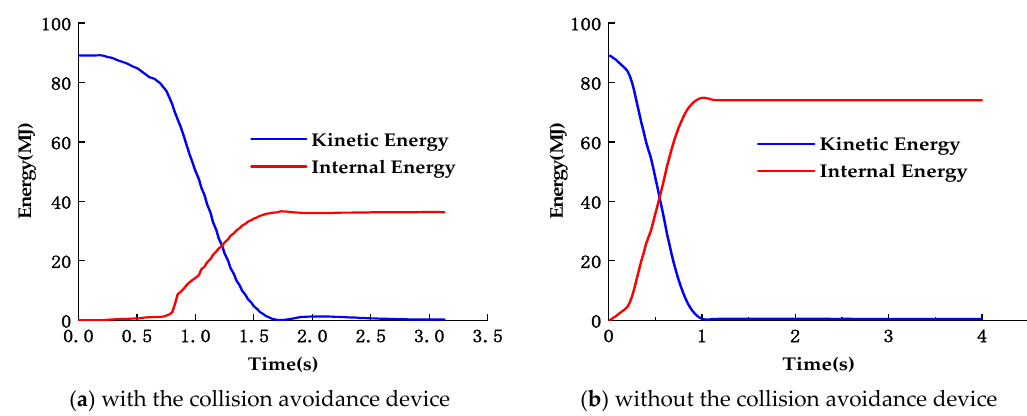
Figure 34. Ship energy diagram at 0 ◦ forward collision.